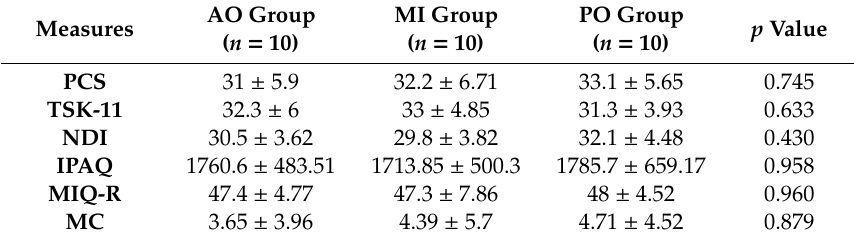
Table 2. Descriptive statistics of self-reported and psychosocial